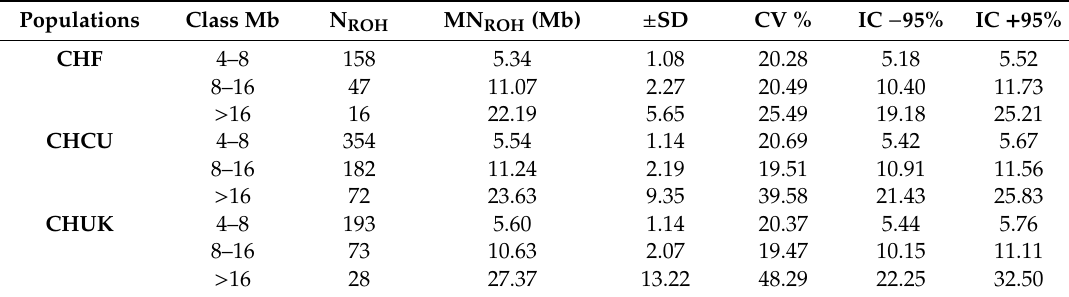
Table 3. Average size of ROH (MN ROH ) in three Charolais